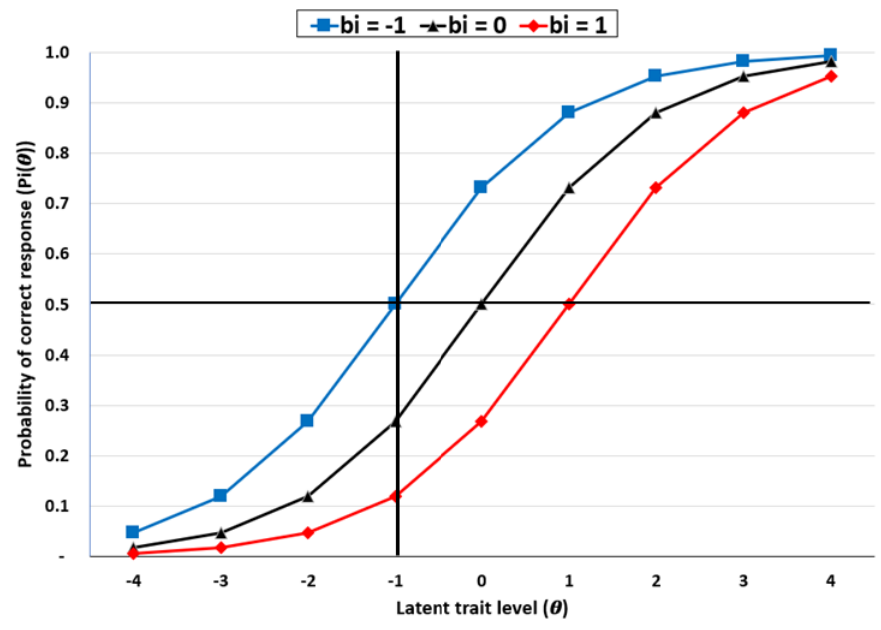
Figure 1. Item characteristic curves, Item Response Theory (IRT) 1PL model.